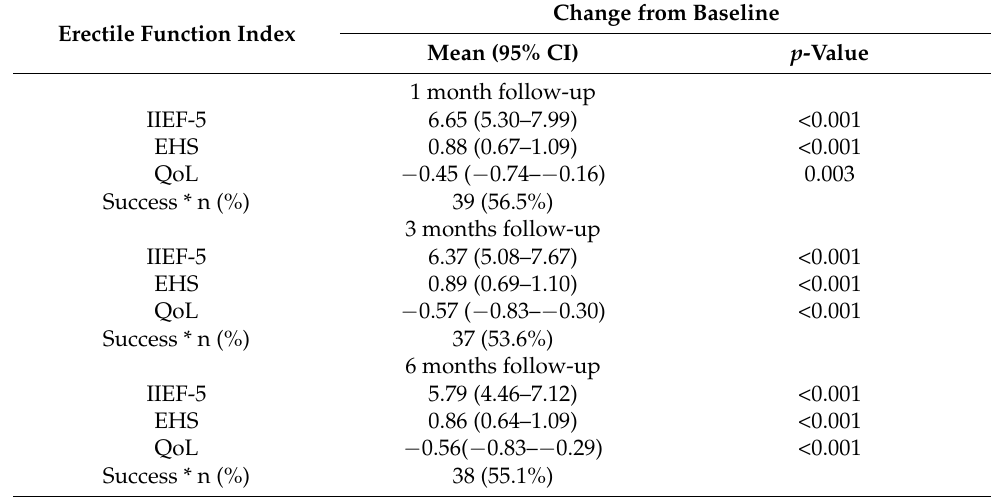
Table 2. Time-phased therapeutic effect of